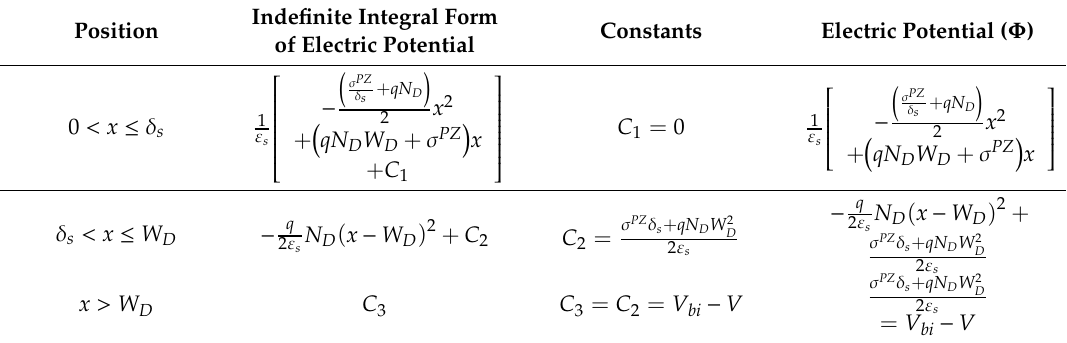
Table A3. Derivations of electric potential distribution of the piezoelectric Schottky